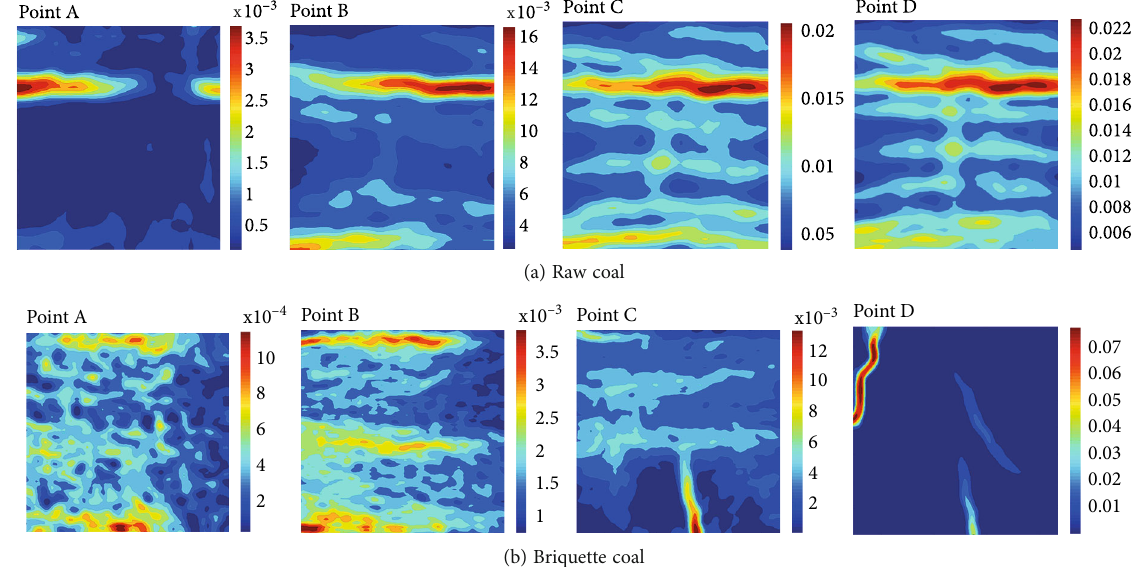
Figure 6: Strain fi elds at di ff erent loading